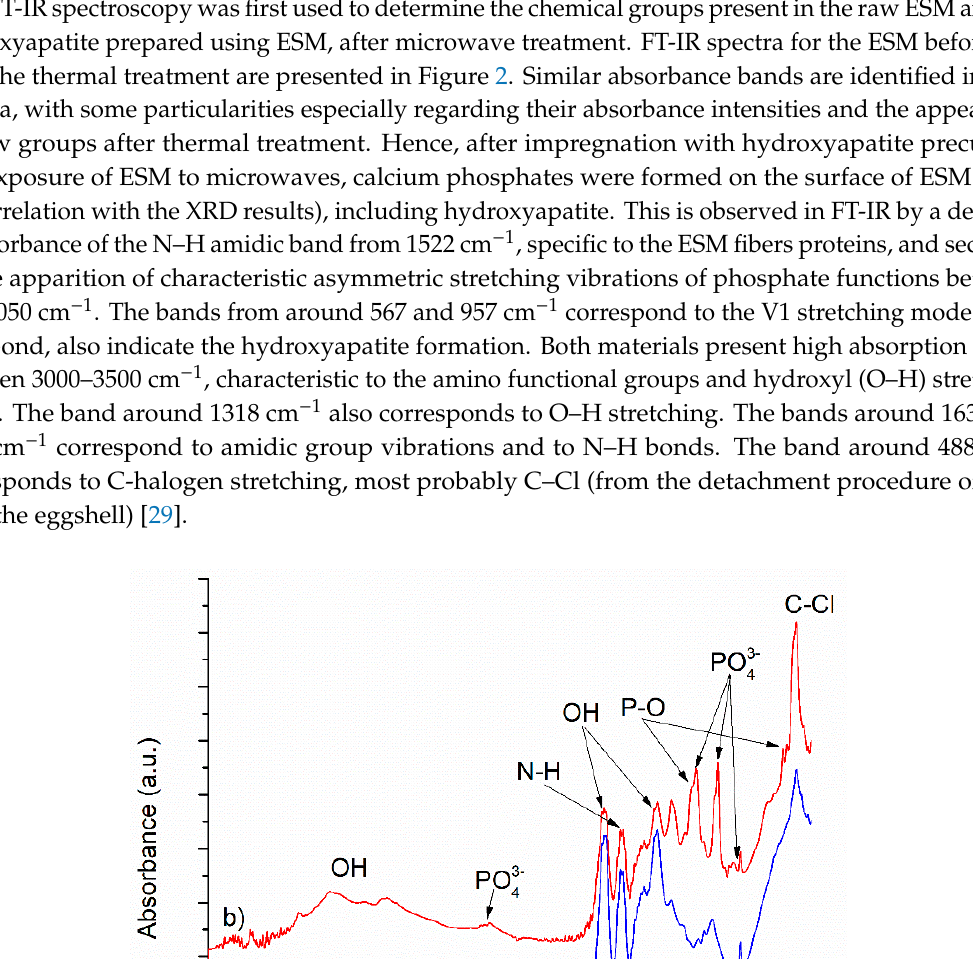
Figure 1. XRD analysis of microwave synthesized hydroxyapatite on ESM.